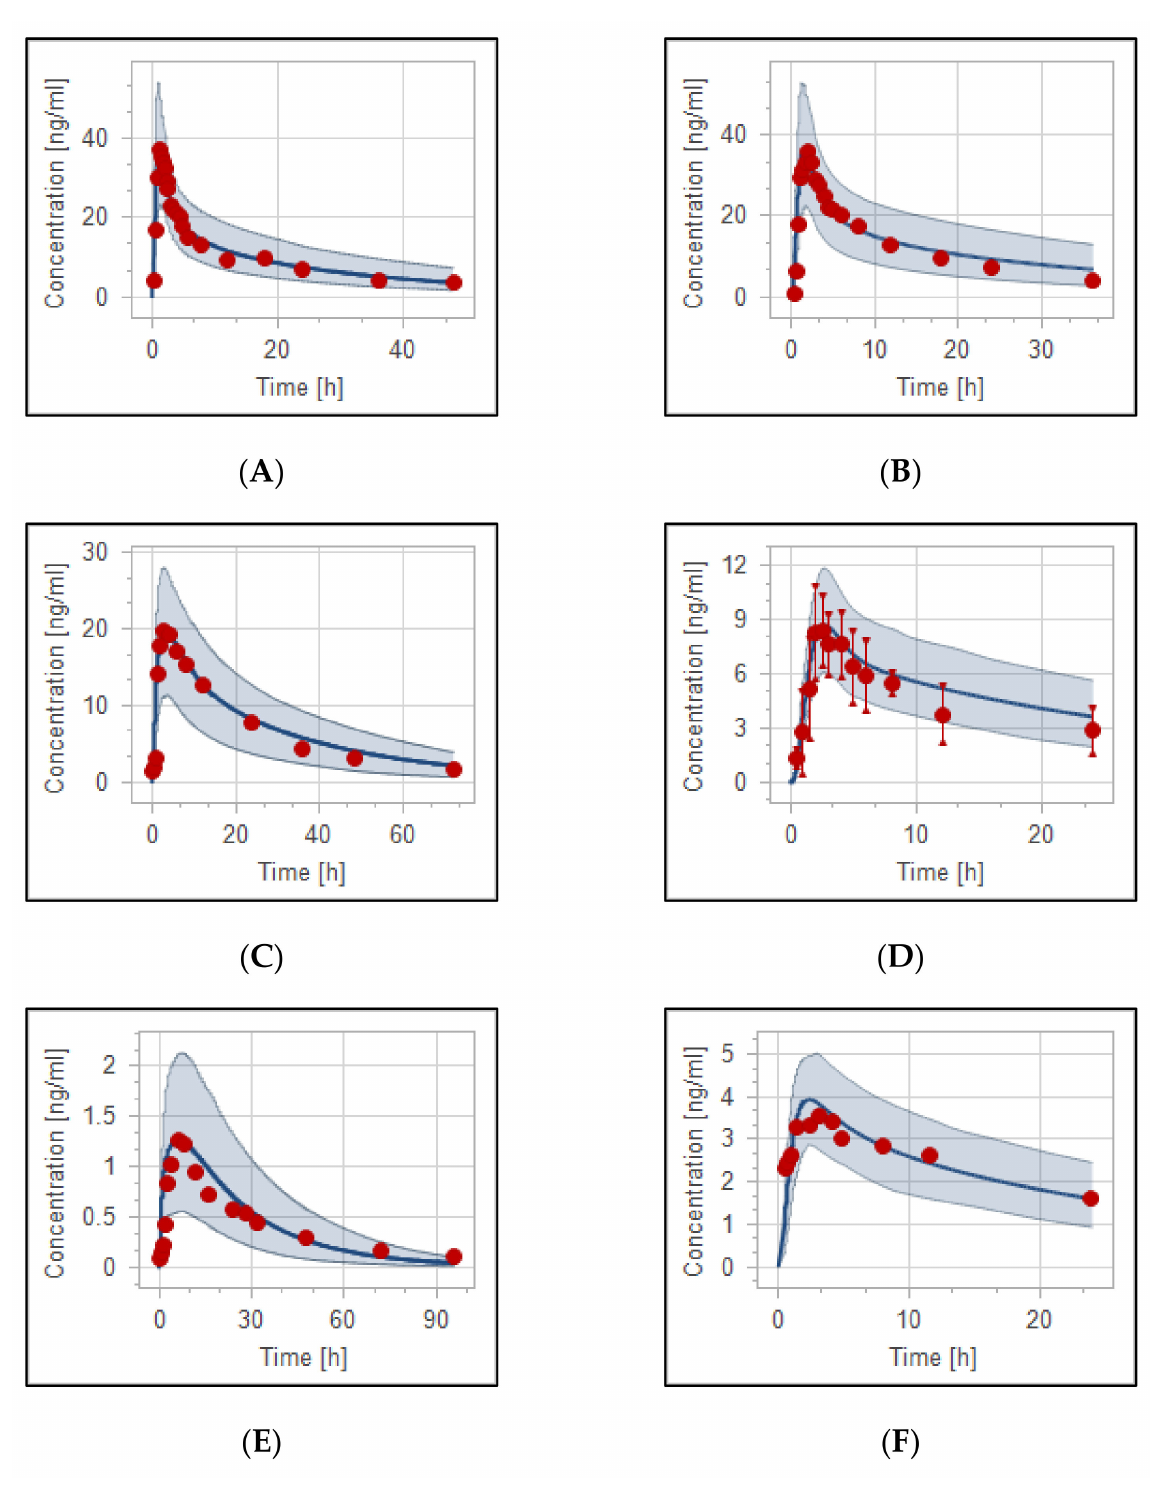
Figure 3. Plasma concentration–time profiles of haloperidol in adult healthy and psychotic otherwise healthy populations after oral administration of haloperidol. ( A ) 0.503 mg/kg [40], ( B ) 0.5 mg/kg [41], ( C ) 0.5 mg/kg [42], ( D ) 10 mg [48], ( E ) 5 mg [49], ( F ) 2 mg [46]. Observed data are depicted as red circles and means of simulations are depicted as solid blue lines with the 5th–95th predictive range as blue shaded